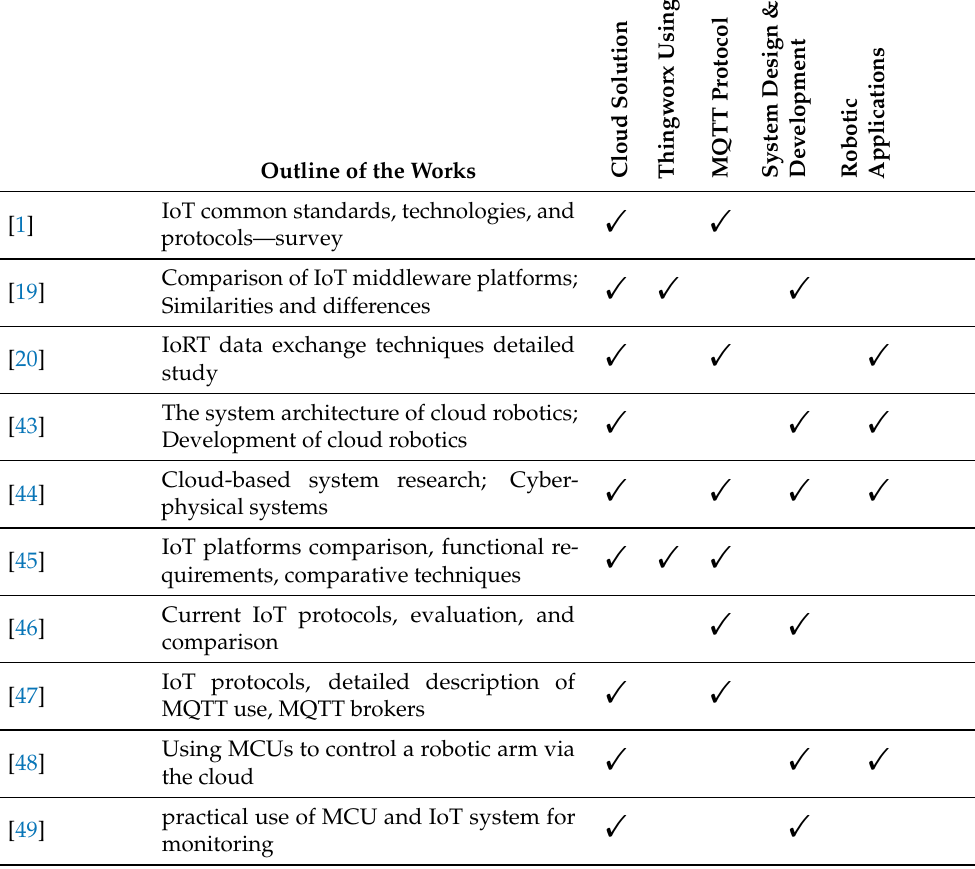
Table 3. This table contains an overview of articles related to concepts used in our work.